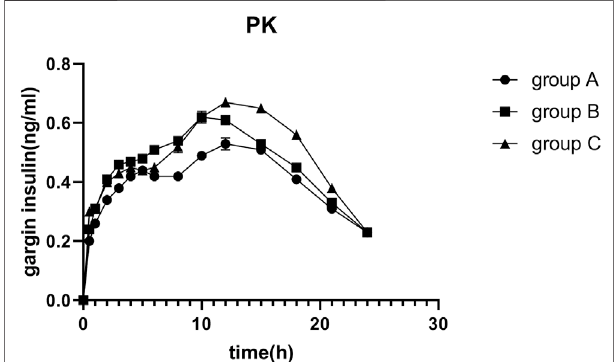
FIGURE5| Meaninsulinglargineconcentrationversustimepro fi lesafter 0.4 IU/kg doses of glargine insulin in healthy volunteers. The error bars represent the 95% con fi dence intervals. Glargine concentration was higher than that in the others, but there were no statistical differences among